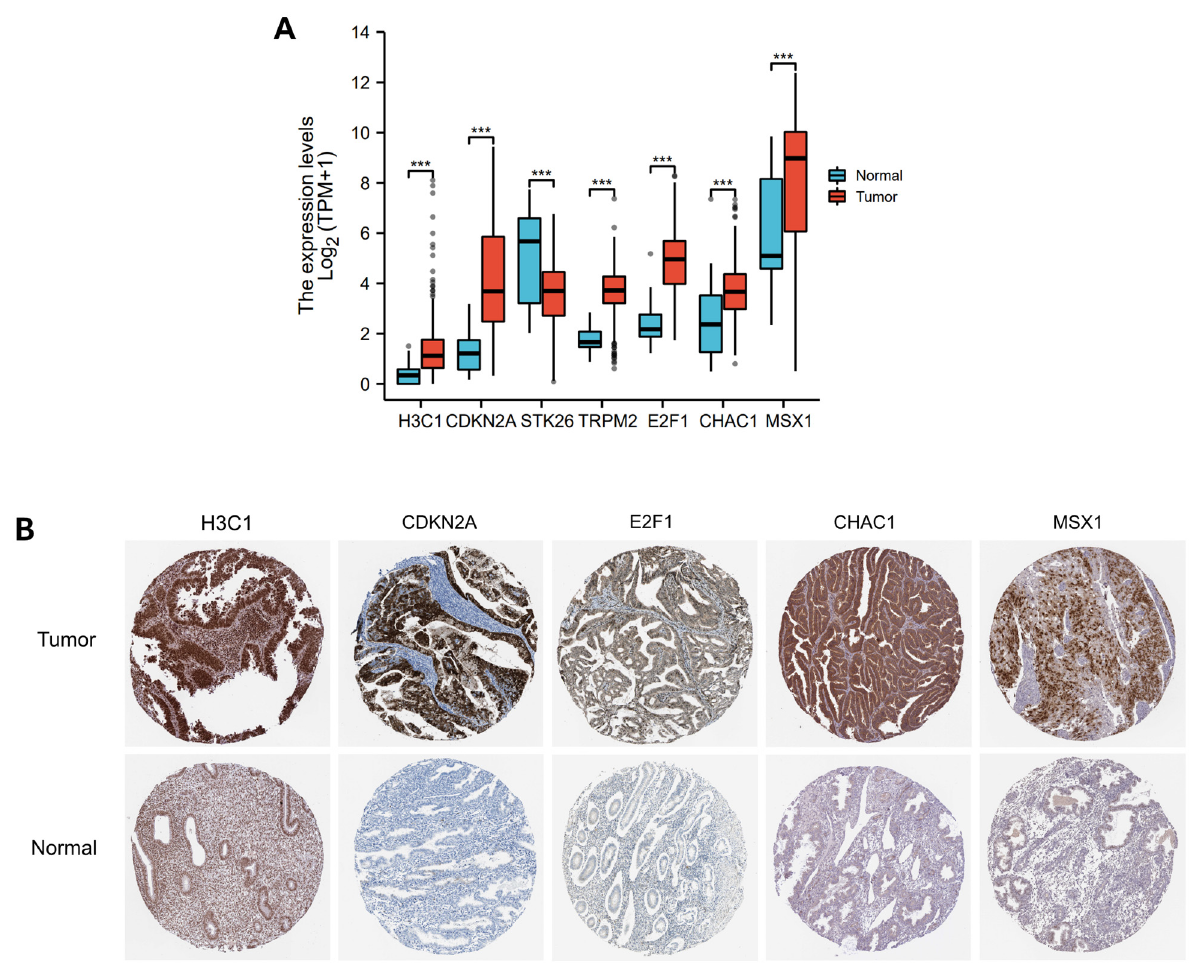
Figure 9. The protein level of the 7 OSRGs in UCEC tissues and normal tissues: ( A ) mRNA levels of the 7 OSRGs in TCGA; ( B ) Immunohistochemistry verification of seven OSRGs’ expression in the HPA database. Note: UCEC: uterine corpus endometrial carcinoma; OSRGs: oxidative stress-related genes. *** represents p < 0.0001.